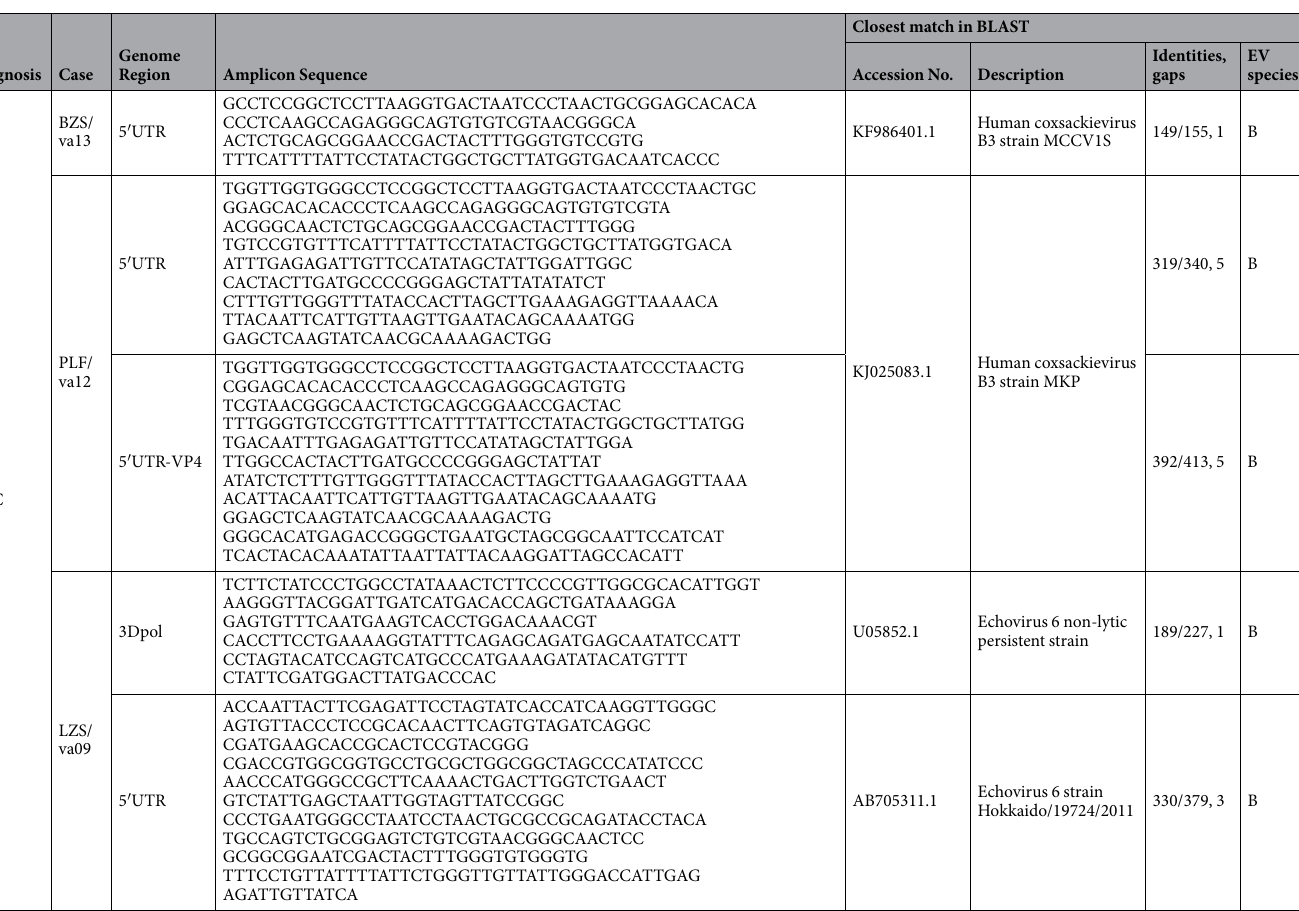
Table 5. Sequence of enterovirus amplicons obtained from cases of post-polio syndrome (PPS), type 1 diabetes (T1D), and chronic viral cardiomyopathy